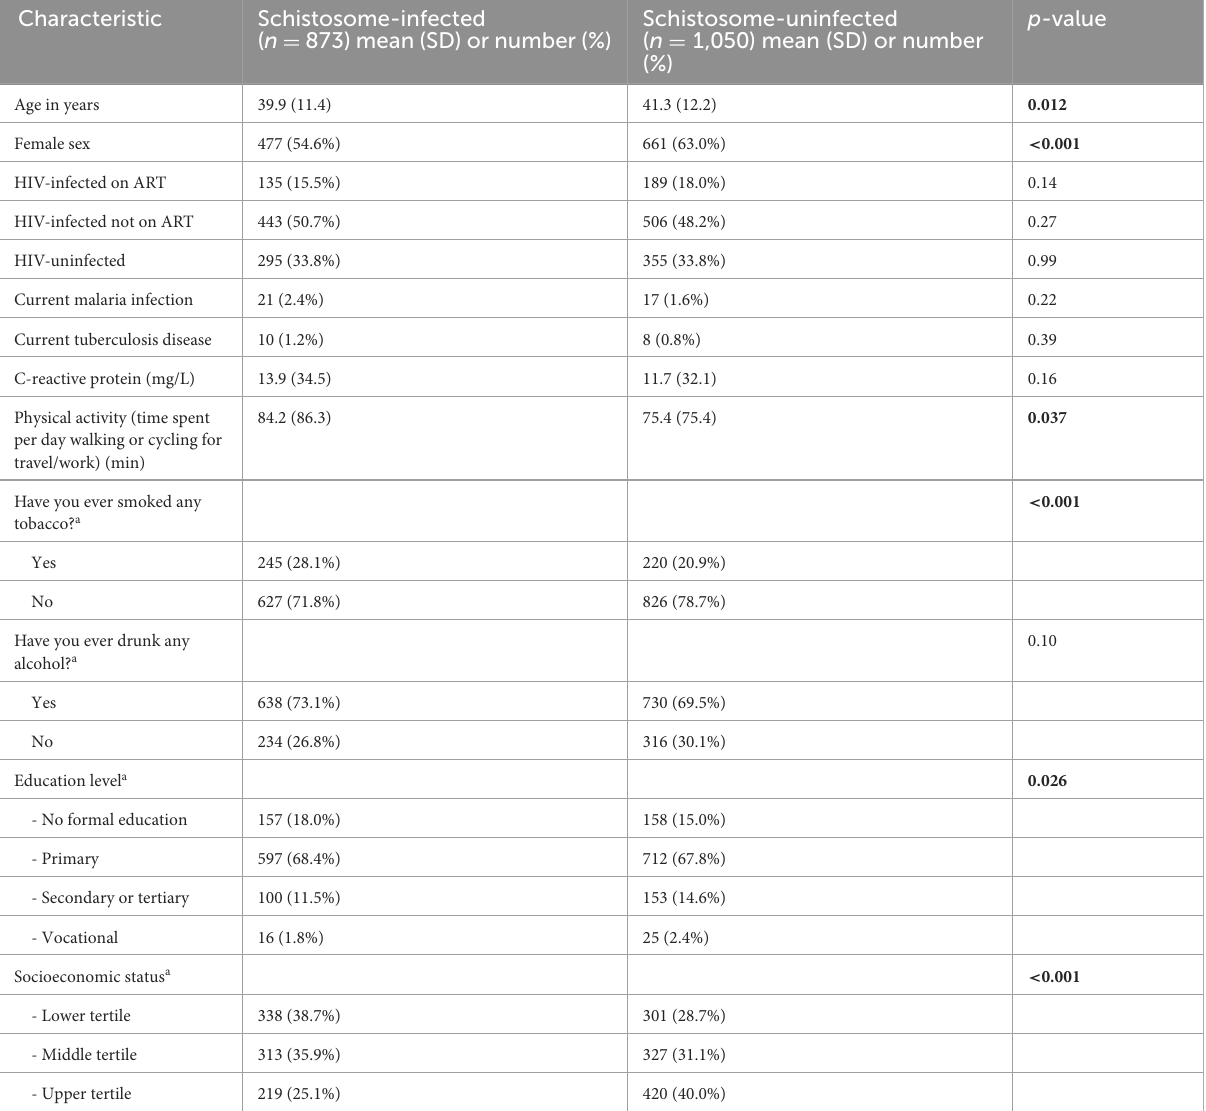
TABLE 1 Sociodemographic and other characteristics in schistosome-infected vs. uninfected individuals.